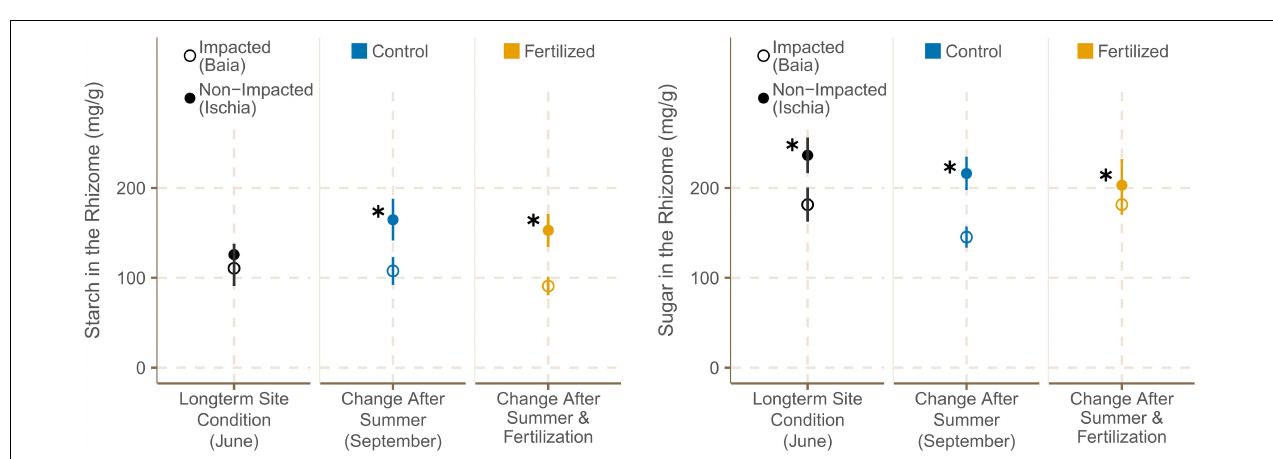
FIGURE 5 | Starch and sugar concentrations [mg g − 1 ] in leaves (mean ± SE) of P. oceanica plants ( n = 6) in fertilized and control plots from different sites in June and September 2019. (cid:81) Shows significant differences between impacted (Baia) and non- impacted (Ischia) areas. (cid:61) Indicates if there seasonal differences between June and September and (cid:66) states if there are differences between control and fertilized plots.